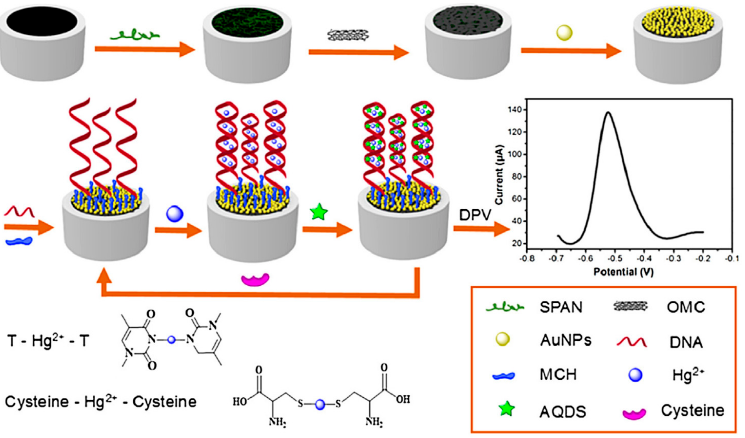
Figure 12. Assembly and detection mechanism of an OMC-DNA-based biosensor for mercury ions (SPAN, self-doped polyaniline; MCH, 6-mercaptohexanol; AQDS, anthraquinone-2,6-disulfonate) (reproduced from [257]).